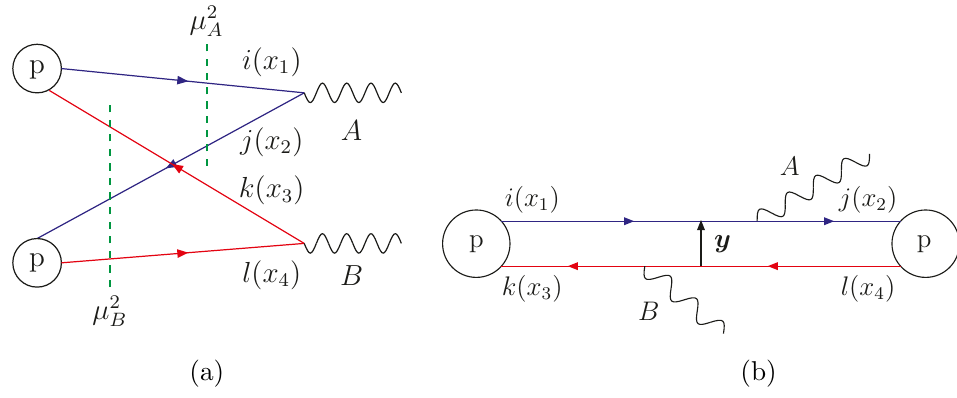
Figure 2 . Sketch of a DPS at a pp collider leading to the production of the (cid:12)nal state A + B : (a) in terms of Feynman diagrams. The green dash-lines symbolise the choice of factorisation scale for each subprocess. The (cid:12)gure (b) o(cid:11)ers another view on the collision. Here, the transverse distance y between the partons is